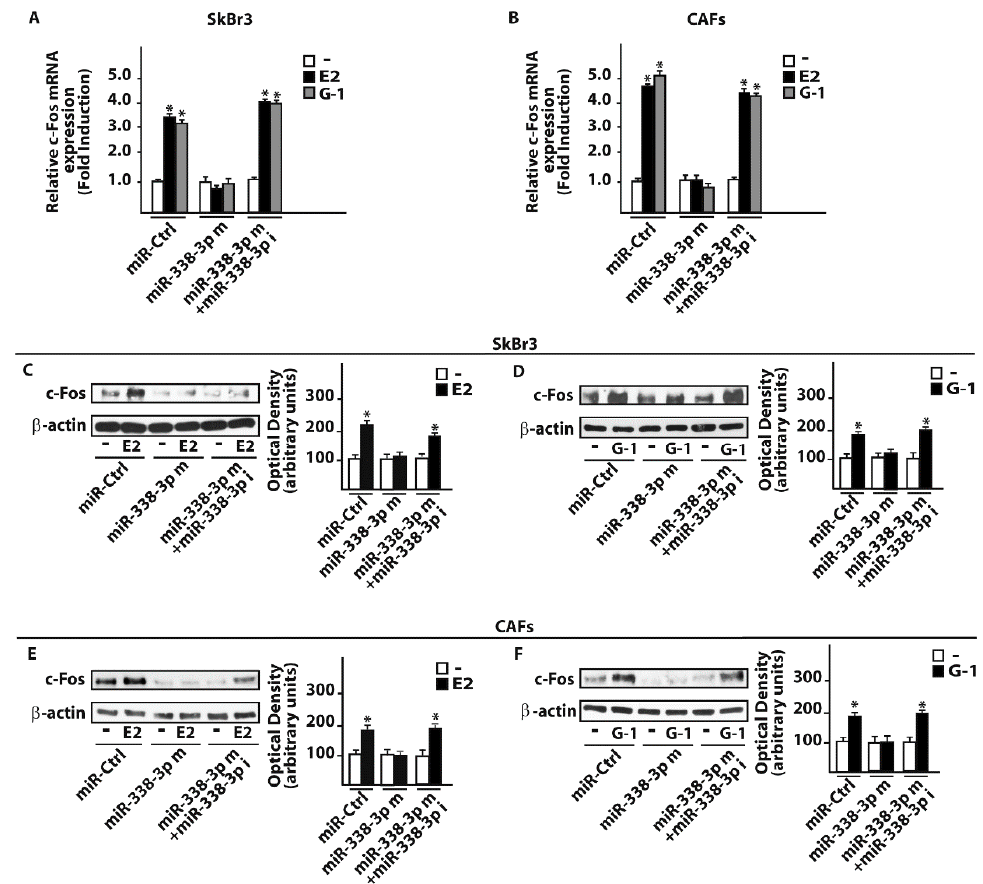
Figure 6. miR-338-3p prevents c-fos induction by E2 and G-1 in SkBr3 cancer cells and CAFs. mRNA levels of c-Fos in SkBr3 cancer cells ( A ) and CAFs ( B ) transfected for 48 h with 25 nM miR-Ctrl or miR-338-3p mimic (miR-338-3p m) in combination or not with 50 nM miR-338-3p inhibitor (miR-338-3p i) and then treated for 4 h with 100 nM E2 or 100 nM G-1. Each column represents the mean ± SD of three independent experiments performed in triplicate. c-Fos protein levels in SkBr3 cancer cells ( C, D ) and CAFs ( E, F ) transfected for 48 h with 25 nM miR-Ctrl or miR-338-3p mimic (miR-338-3p m) in combination or not with 50 nM miR-338-3p inhibitor (miR-338-3p i) and then stimulated for 4 h with 100 nM E2 or 100 nM G-1. Side panels show densitometry analysis of the blots normalized to the loading control β -actin. (*) indicates p < 0.05, for cells receiving treatments vs cells treated with vehicle (-).